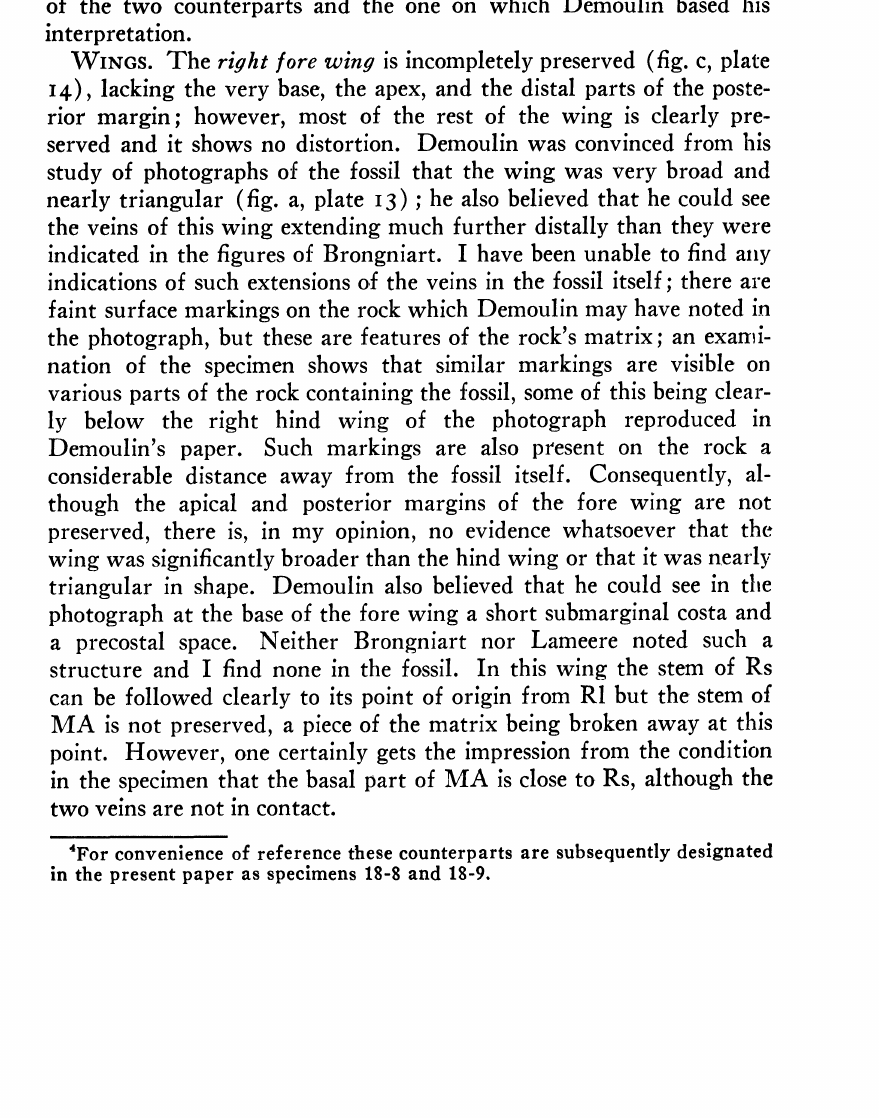
figure a. 4 The fossil consists o. a nearly whole insect, with outstretched but somewhat distorted wings. Subsequent to Brongniart’s study of the fossil, as noted by Lameere (97), specimen 8-8 was covered with shellac, which rendered the venation of that counterpart nearly invisible. The shellac was still on the fossil in 938 when I examined the specimen, but it has subsequently been removed, so that the vena- tional details are now discernible. The fore wing, not quite complete, is 2 mm. long; the hind wing, complete, is 2I mm. long and 7 mm. wide. The body length excluding cerci is 25 ram. In the ollowing or reference, this being the better, discussion I am using specimen 8-9 of the two counterparts and the one on which Demoulin based his